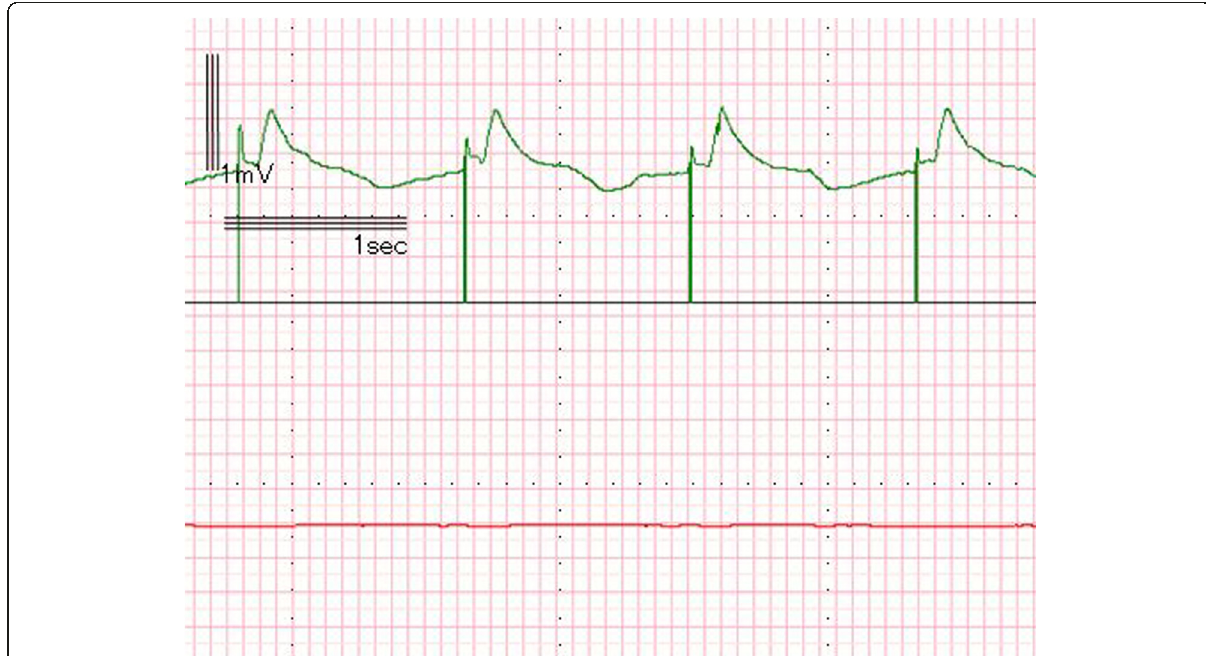
Fig. 1 ECG and pressure waveform at 50 bpm VVI pacing. Each VVI pacing spike captures a QRS